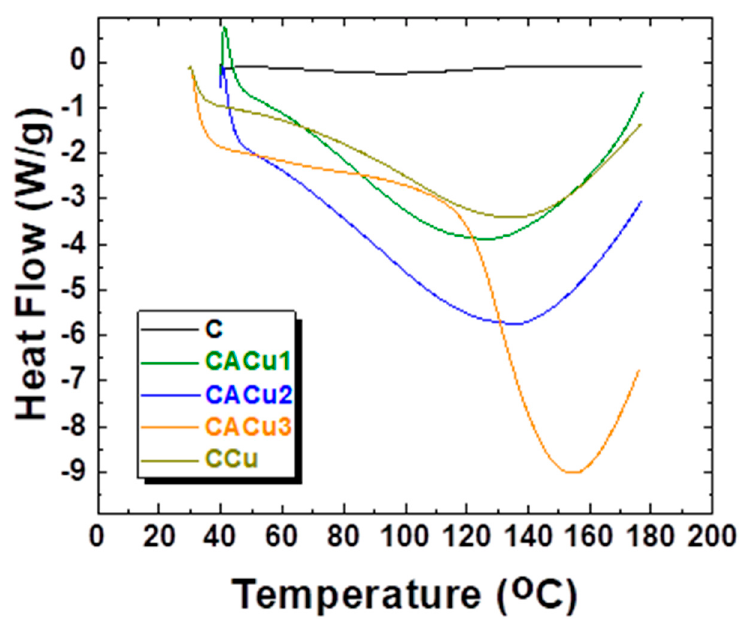
Figure 5. DSC of chitosan (C)), ternary composites (CACu1, CACu2, CACu3) and binary composite (CCu) materials.